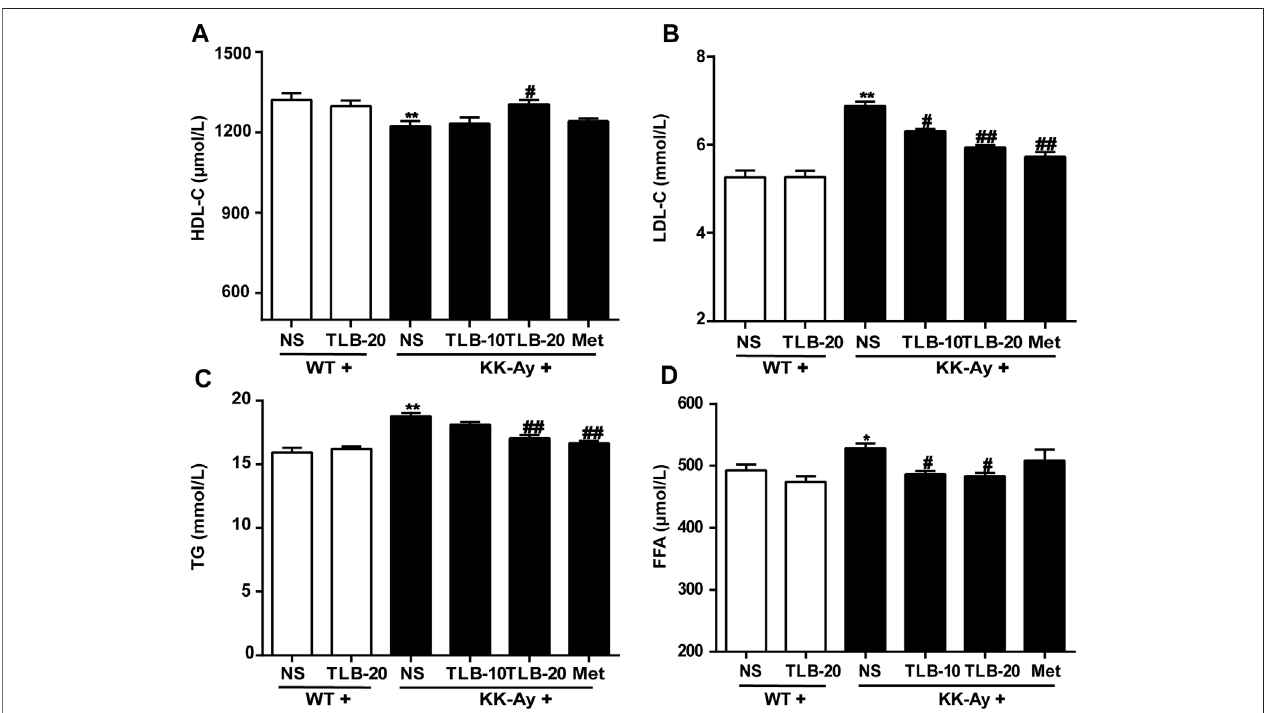
FIGURE5| TLBalleviatedlipidmetabolism disorderinKK-Aymice. (A) HDL-Ccontent. (B) LDL-Ccontent. (C) TGcontent. (D) FFAcontent. *p < .05, **p < .01 vs. WT group; # p < .05, ## p < .01 vs. KK-Ay group; n = 6 – 9 per group, mean ± SEM.